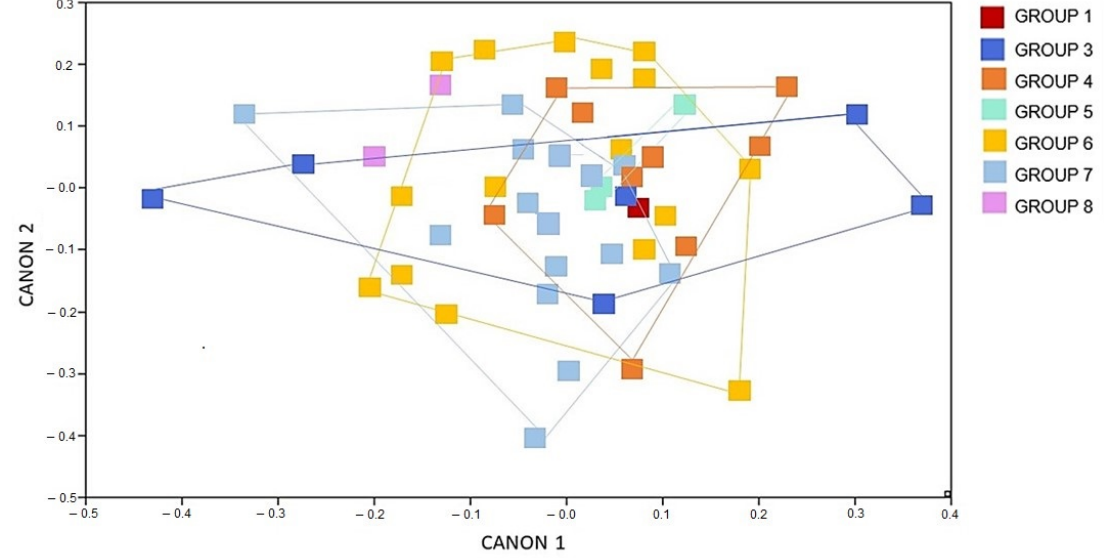
Figure 2. Canonical variate analysis showing the wing shape influence of the of Triatoma brasiliensis brasiliensis females from various states and years (1912–2014) Canon represents the canonical variate dimension.